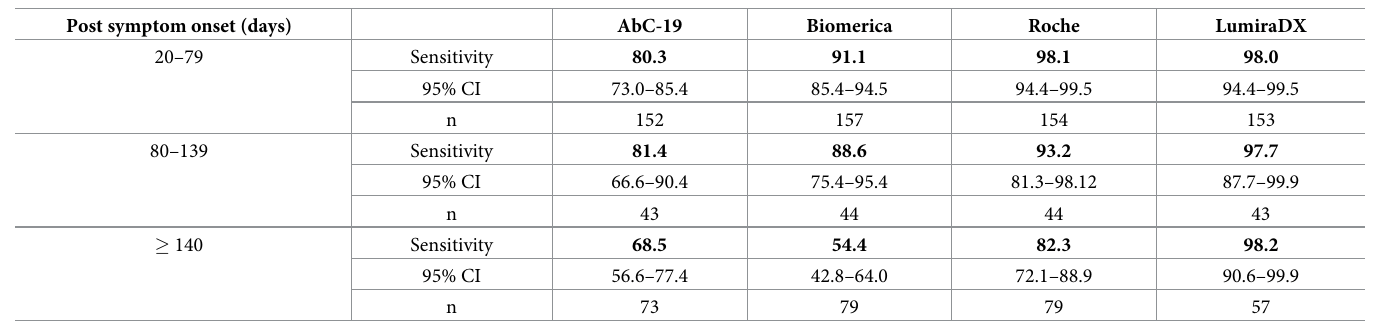
Table 3. Sensitivity against time post symptom onset.